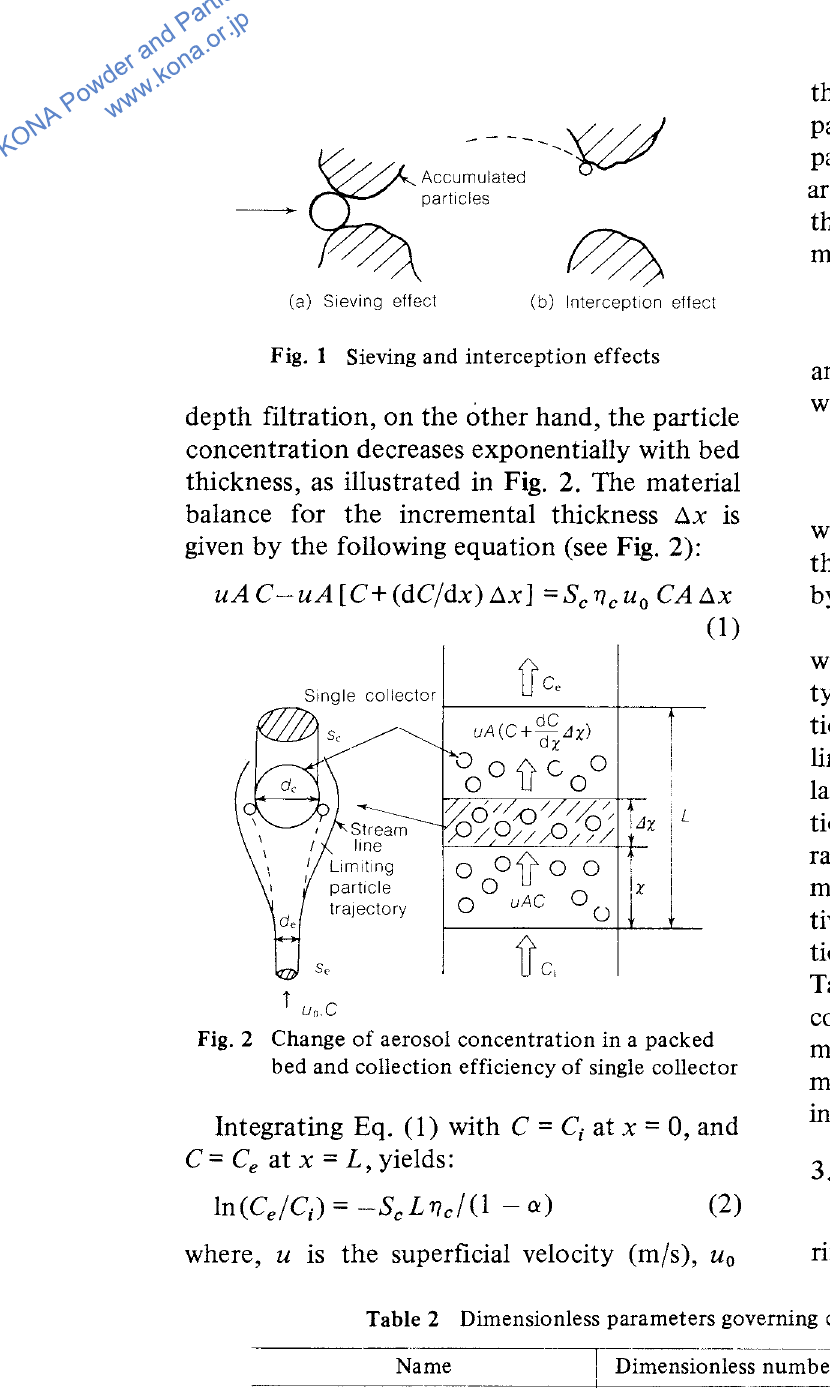
Table 2 Dimensionless parameters governing collection efficiency of single